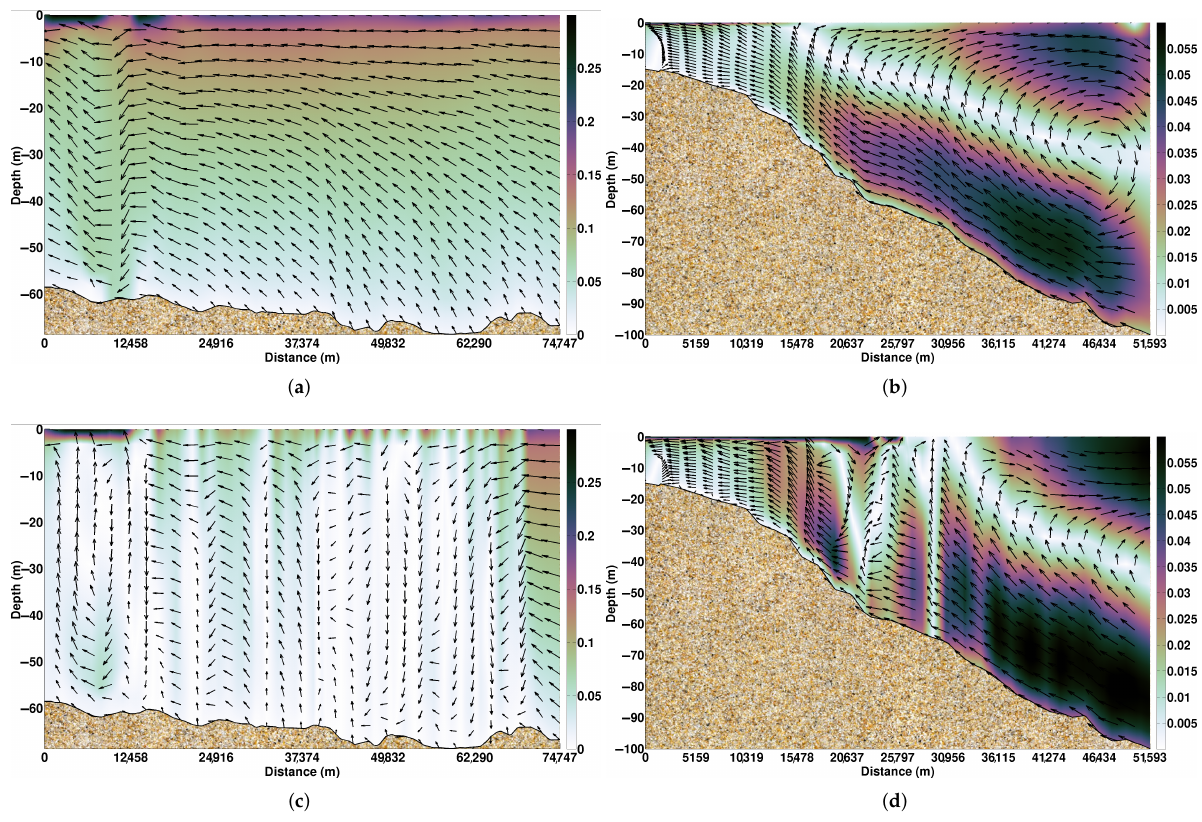
Figure 9. Vertical cross sections for the Rio Grande do Sul turbines site; colored surface shows mean velocity (m · s − 1 ) while vectors show direction. Simulation without the presence of turbines (upper panel) and with the turbines (lower panel). ( a , c ) Refers to RS1 transect; ( b , d ) refers to RS2 transect. See Figure 1b. for a better location of the